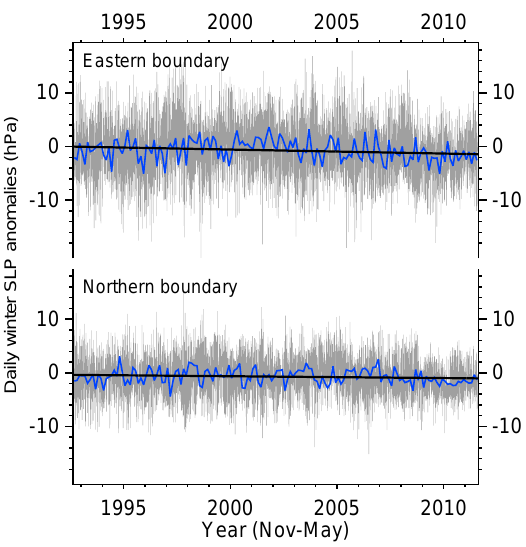
Fig.10. TimeseriesofSeaLevelPressure(SLP)gradientanomalies(OctobertoMay)acrosstheeasternandnorthernboundaries. Fig. 11. Time series of winter (December–February) Dipole linerepresentsthemonthlydata. Thetrendlineiscalculated inaleastsquaresensefromthedailyanomalies. Anomaly (DA) and Arctic Oscillation (AO) index vs. normalized monthly anomalies of detrended total ice area flux out of the Laptev Sea from 1992 to